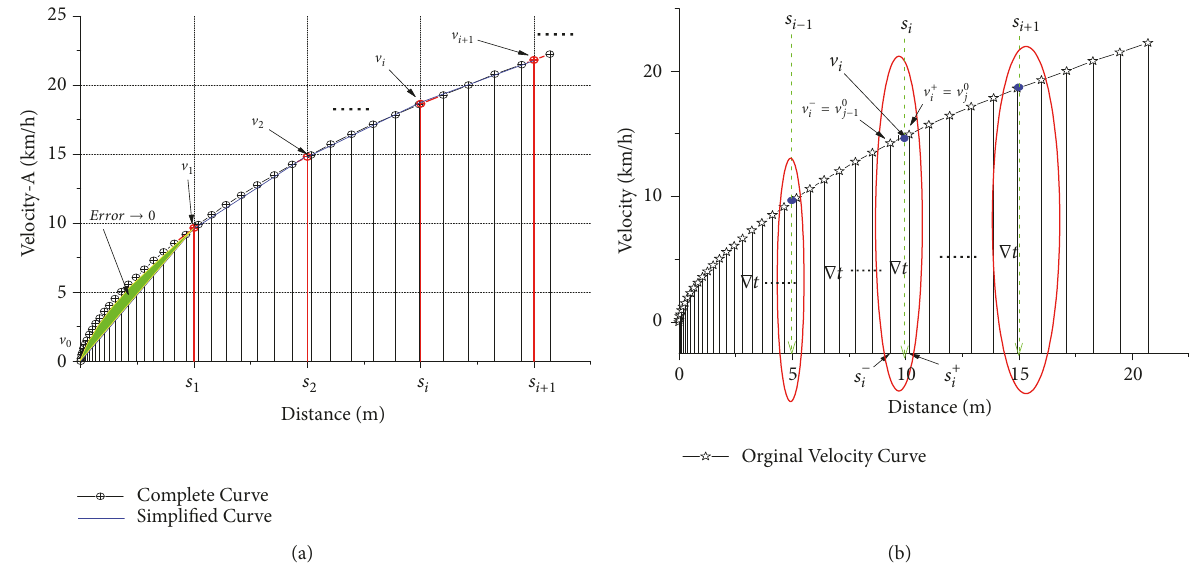
Figure 6: Dimension reduction process of velocity profile. (a) Get the { V 0 .. . V 𝑖 . .. V 𝑛 } . (b) Error in simplified profile.